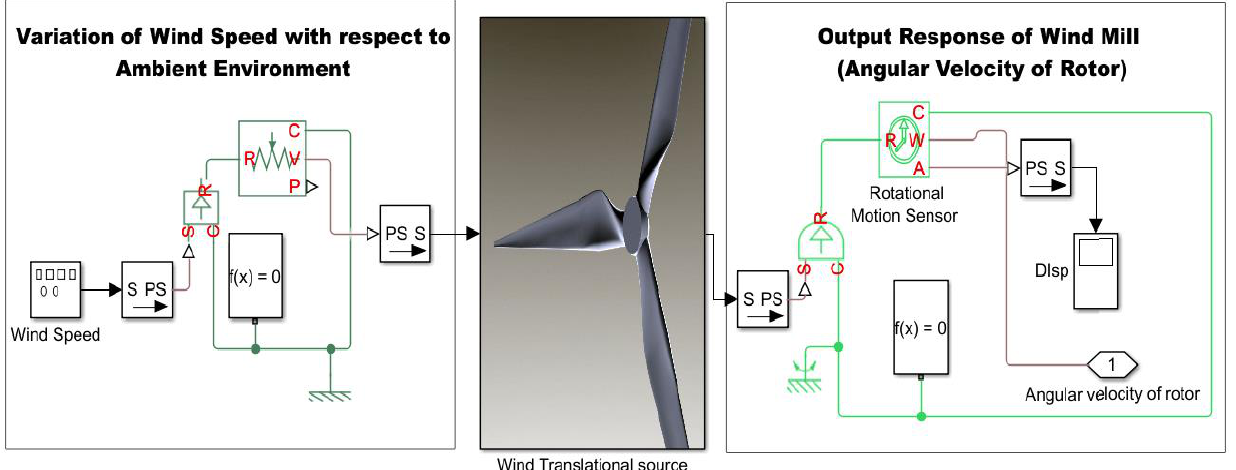
Figure 4. Model of windmill on SIMSCAPE.